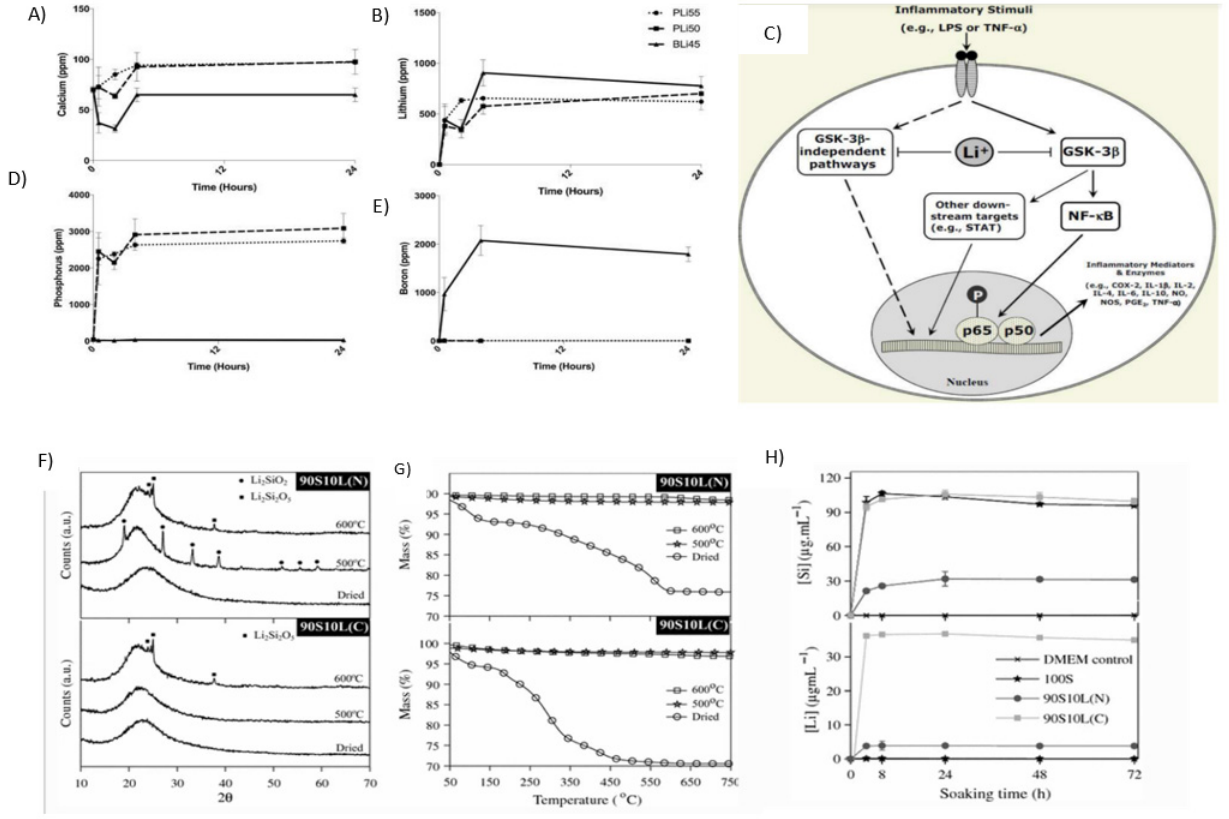
Figure 8. ( A – D ) shows that in 4 h, the concentration of lithium in the cell is more than 500 ppm and remains stable up to 24 h; elemental analysis results are shown ( A ) Ca, ( B ) Li, ( C ) P, and ( D ) B after the soaking of 6mg/mL LiPBG and LiBBG for 24 h. Adapted from [122]. Reproduced with permission from Dental Materials. ( E ) shows the association between lithium and inflammation. Adapted from [124]. Reproduced with permission from Springer. ( F ) shows XRD patterns. ( G ) shows the TGA results for thermal stabilization of sol–gel glasses at 500 and 600 °C, and ( H ) shows the concentration profiles of lithium and silicon immersed in the DMEM. Adapted from [127]. Reproduced with permission from Springer.